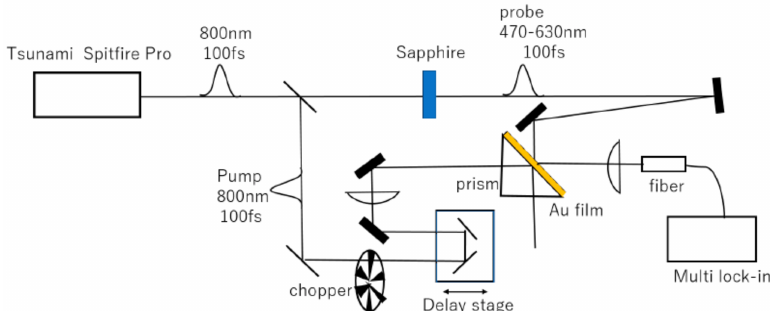
Figure 3. Experimental setup for femtosecond pump-probe spectroscopy of